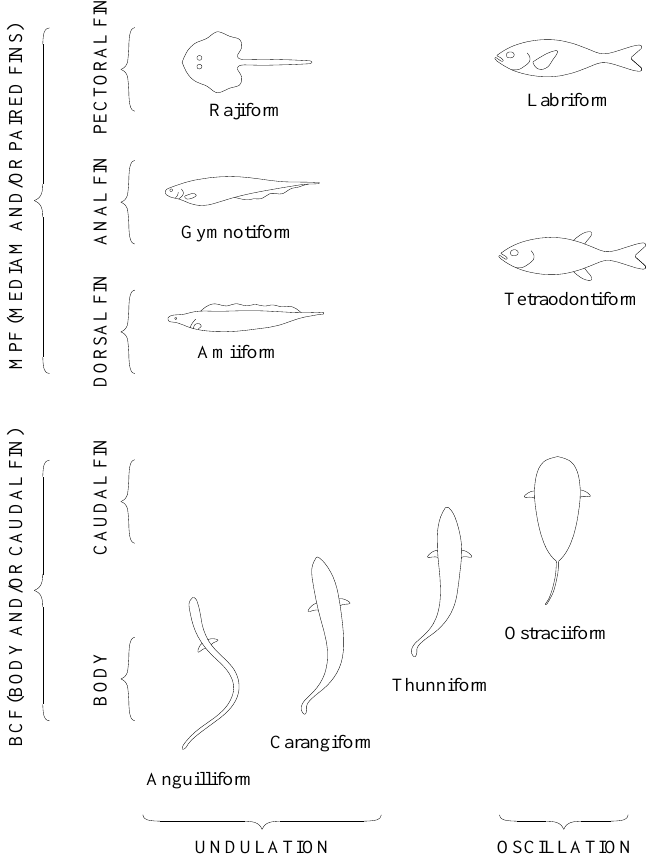
Figure 1. Examples of fish swimming modes.